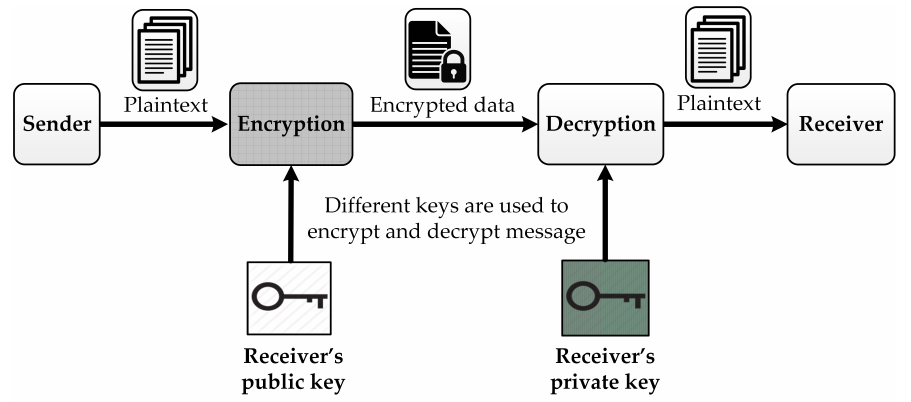
Figure 1. Public-key